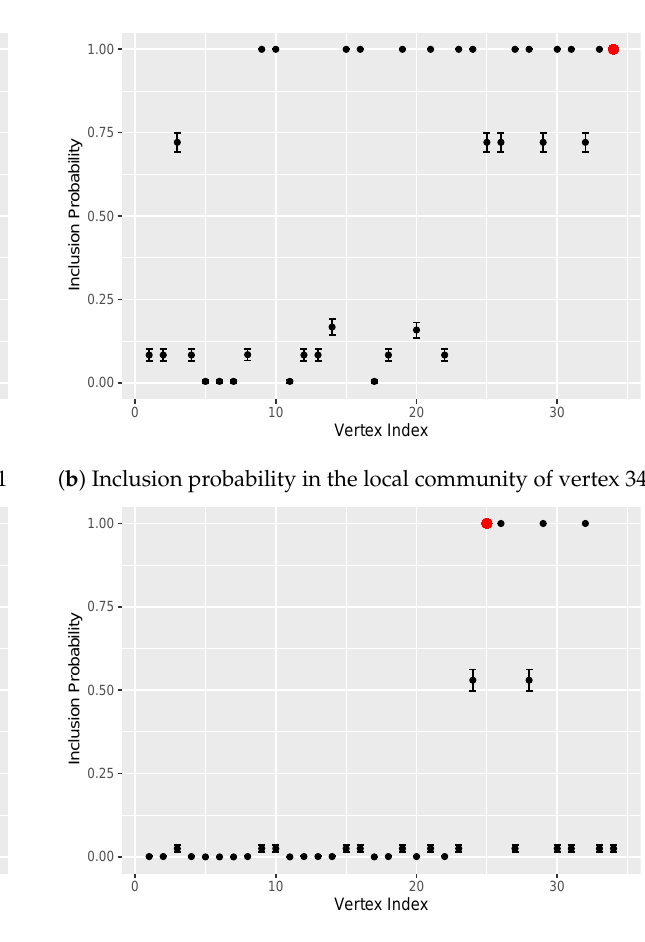
( d ) Inclusion probability in the local community of vertex 25